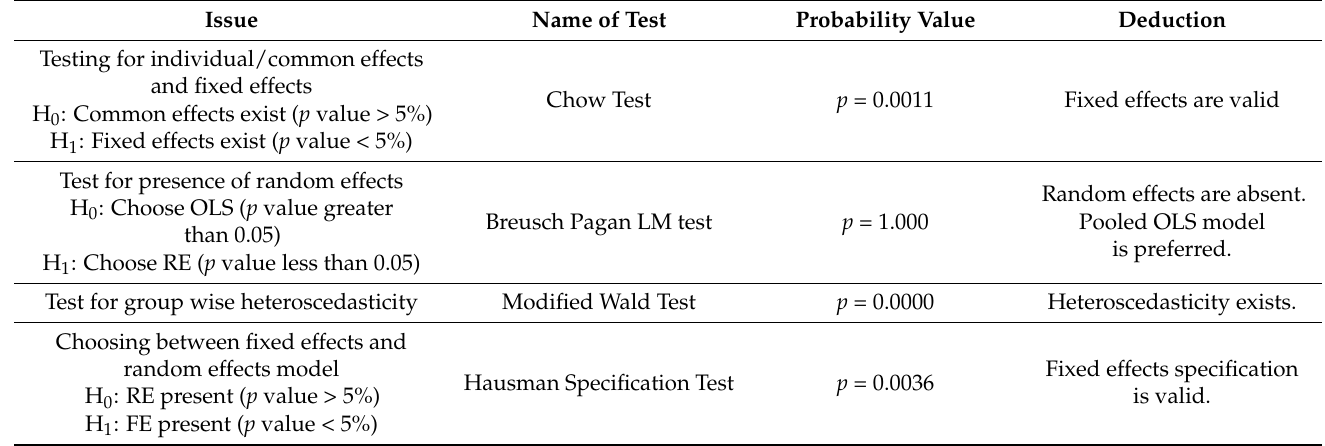
Table 4. Diagnostic Tests Using ROA as a Measure of Performance.